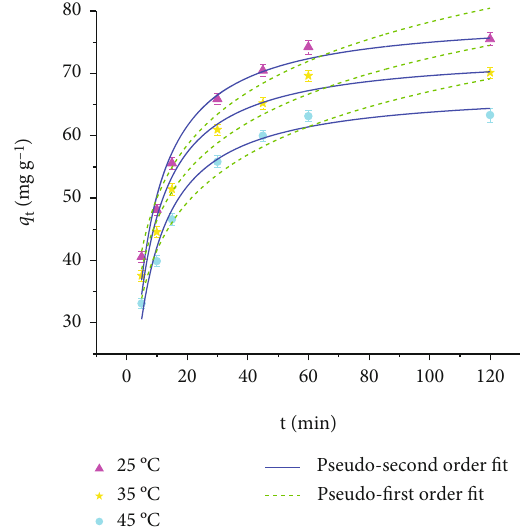
Figure 5: Contact duration in fl uence on uptake of BPA onto AgNP-SB- β CD nanocomposites ( C 0 = 100 mgL -1 , V = 10 mL, and m = 0 : 01